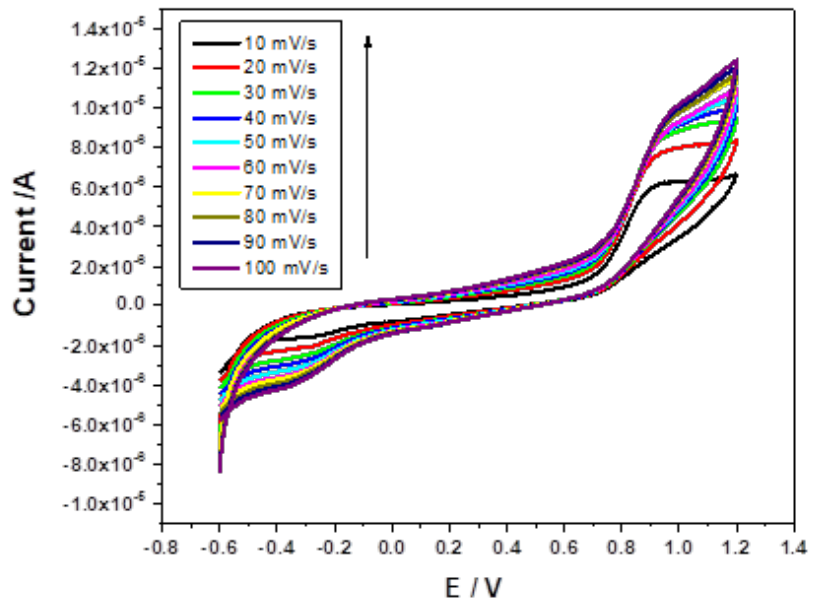
Figure 10. Effect of scan rate (from 10 to 100 mV/s) on the cyclic voltammograms for 1 × 10 − 3 M fenitrothion in phosphate borate buffer pH 8 in presence of CTAB with 50 mV/s scan rate.